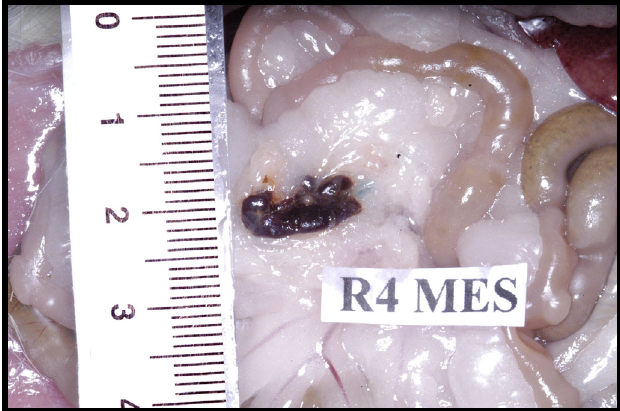
FIGURE 4 - The group III graft, emphasizing its implantation in the mesenterium